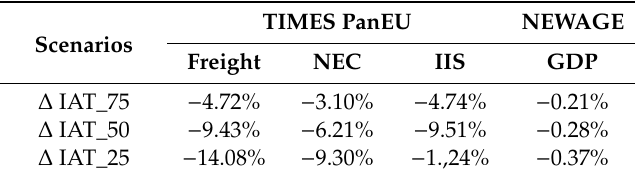
Table 4. Difference in selected energy service demands and GDP relative to GHG_DAM scenario in 2050 in the EU28.